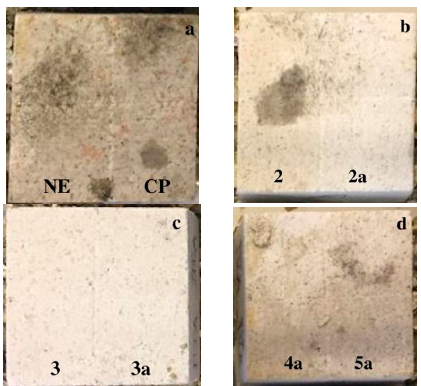
Figure 6. Spontaneous colonization of untreated and treated tufa probes after incubation for 90 days. ( a ) Untreated (CP) and NanoEstel treated (NE) probes: both show a remarkable fungal growth, visible as black stains; ( b ) 2 and 2a treated probes: the area treated with 2 is colonized by a black fungus, while that one treated with 2a is rather pristine; ( c ) 3 and 3a treated probes: no spontaneous colonization is observed; ( d ) 4a and 5a treated probes: spontaneous colonization is